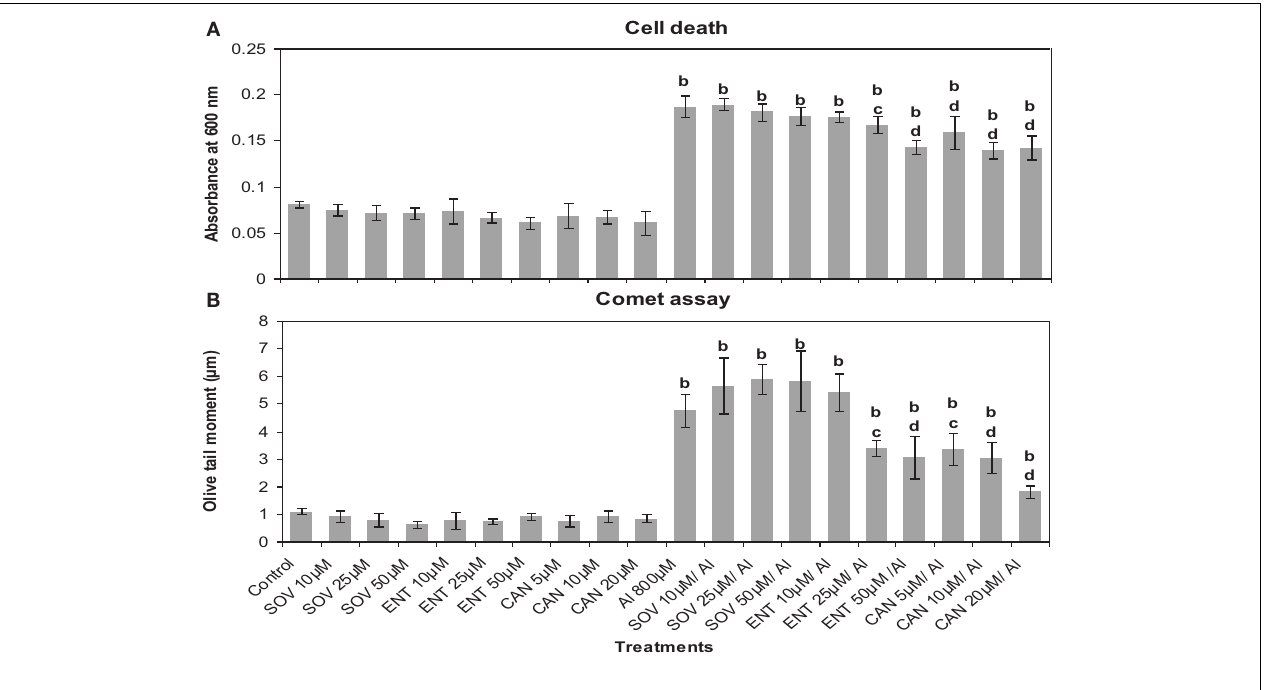
FIGURE 5 | Pre-treatment of protein phosphatase inhibitors: SOV (Na 2 VO 4 ) 10–50 µ M; ENT (endothall) 10–50 µ M; CAN (cantharidin) 5–20 µ M prevented Al-induced cell death (A) and DNA damage (B) in